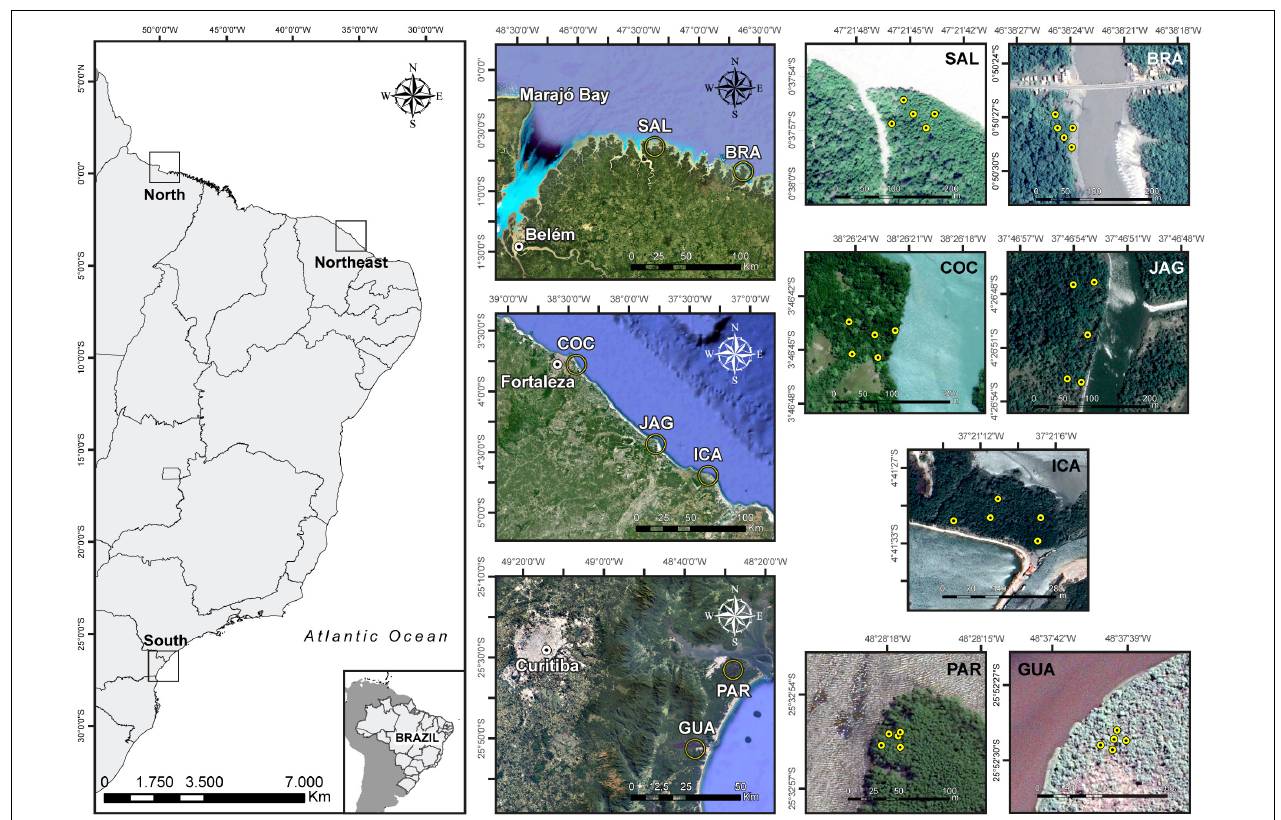
FIGURE 1 | Map indicating the geographical locations of the sampling sites. Five sampling points were sampled at each mangrove, each comprising three subsamples. A total of seven mangroves were studied; in the North: Salinópolis (SAL) and Bragança (BRA); in the Northeast: Cocó (COC), Jaguaribe (JAG), and Icapuí (ICA); and in the South: Paranaguá (PAR) and Guaratuba